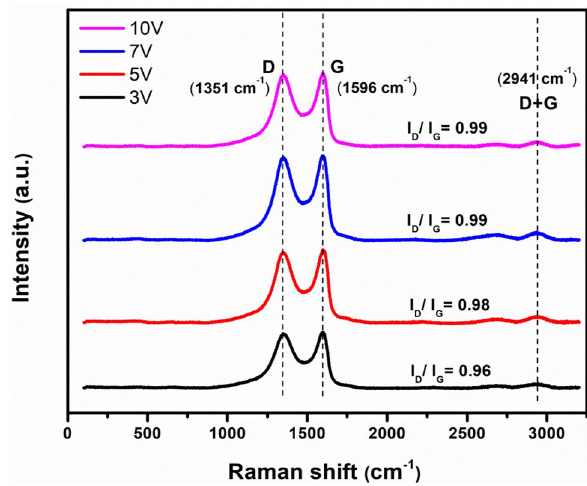
Fig. 2 Raman spectrograph of GO coated steel samples deposited at 3 to 10 V